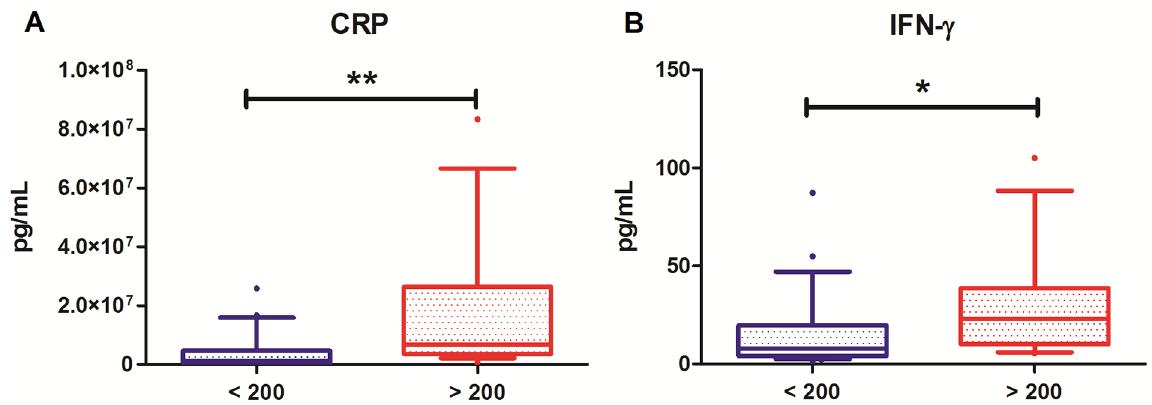
Fig 1. Distribution of serum biomarker levels in patients with normal (blue, < 200 mg/kg) and increased (red, > 200 mg/kg) fecal calprotectin levels, shown in boxplots. (A) Serum CRP levels (pg/mL). (B) Serum IFN- γ levels (pg/mL). (cid:3) P < 0.05; (cid:3)(cid:3) P < 0.01.